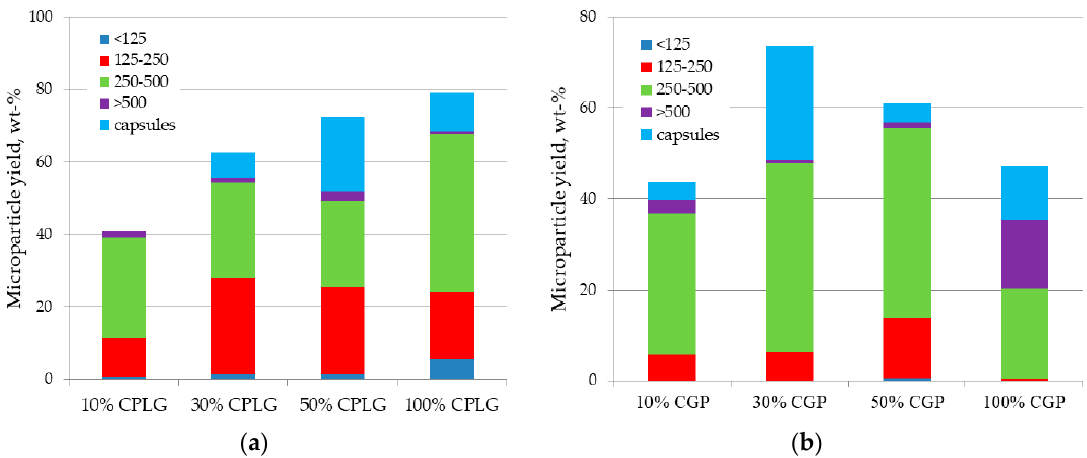
Figure 3. Effect of ( a ) CPLG or ( b ) CPG copolymers content in oil phase on the processing yield and size distribution of the microspheres.